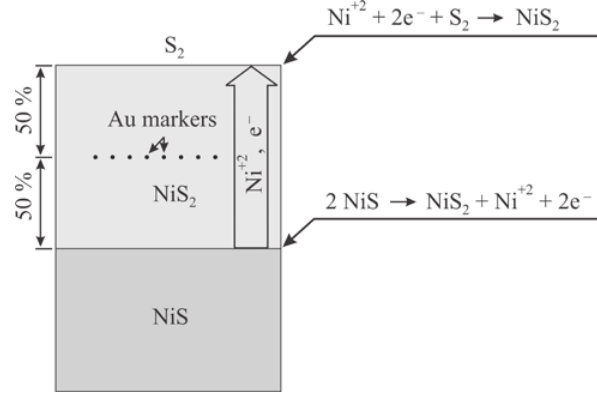
Fig. 5: Marker position in the NiS 2 layer, grown on the surface of NiS as a result of the outward diffusion of cations.